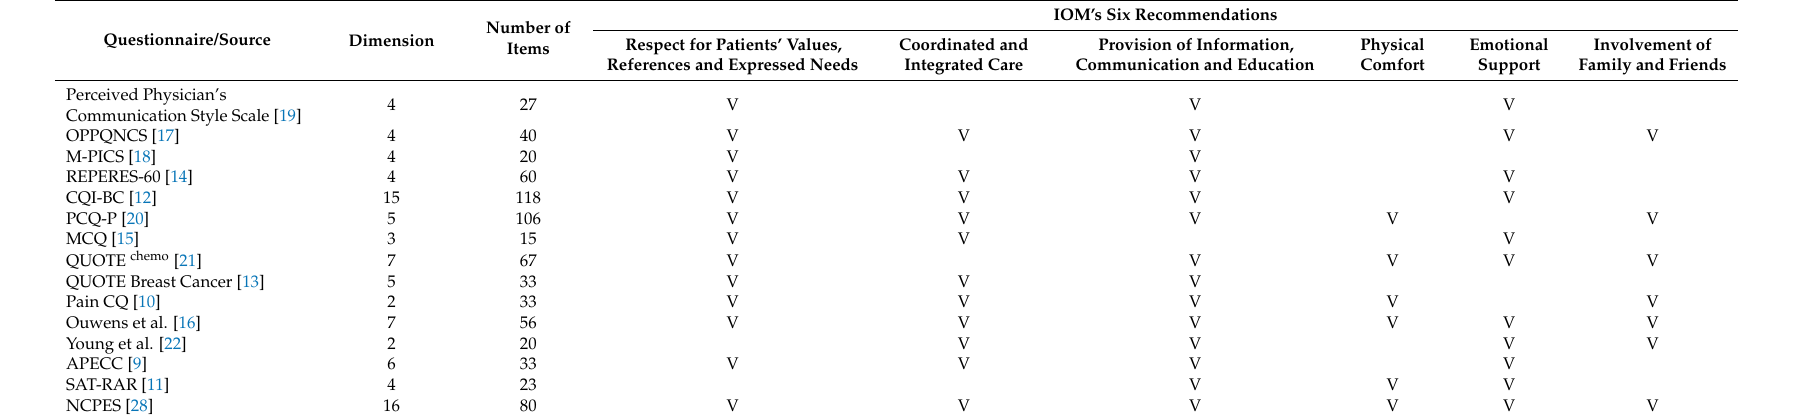
Table 1. Comparison of existing questionnaires.